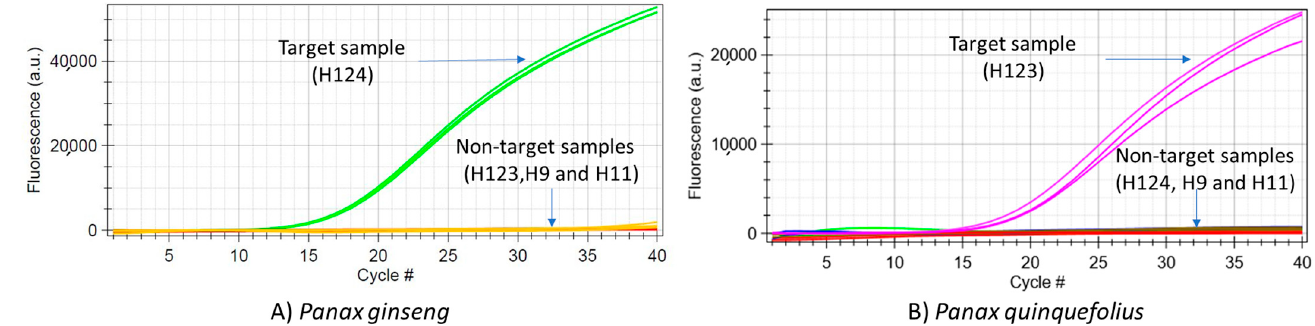
Figure 1. Analytical specificity of Panax ginseng assay ( A ), and Panax quinquefolius assay ( B ), tested on bCUBE platform shows amplification of only target species. In each run, one target, one no template control and three non-targets were tested in triplicate on a 4 × 4 (16 well) cartridge. All target and non-target samples were tested in different runs using multiple cartridges.